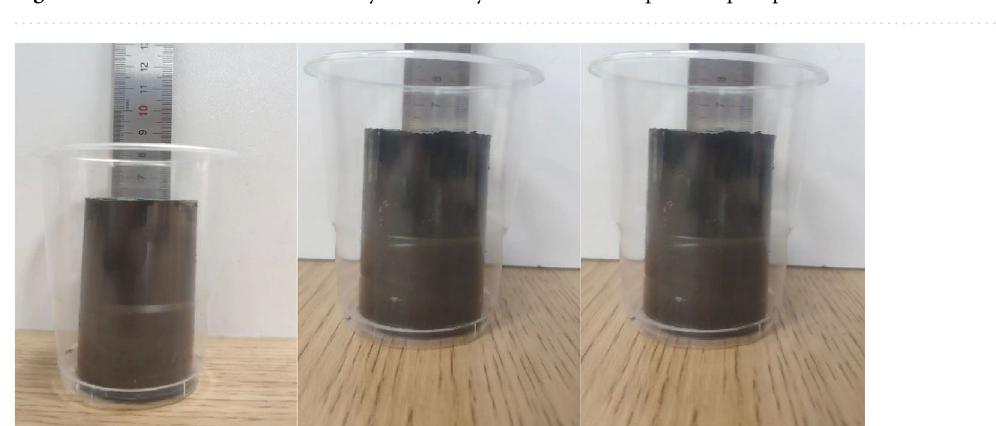
Figure 9. Rock after soil